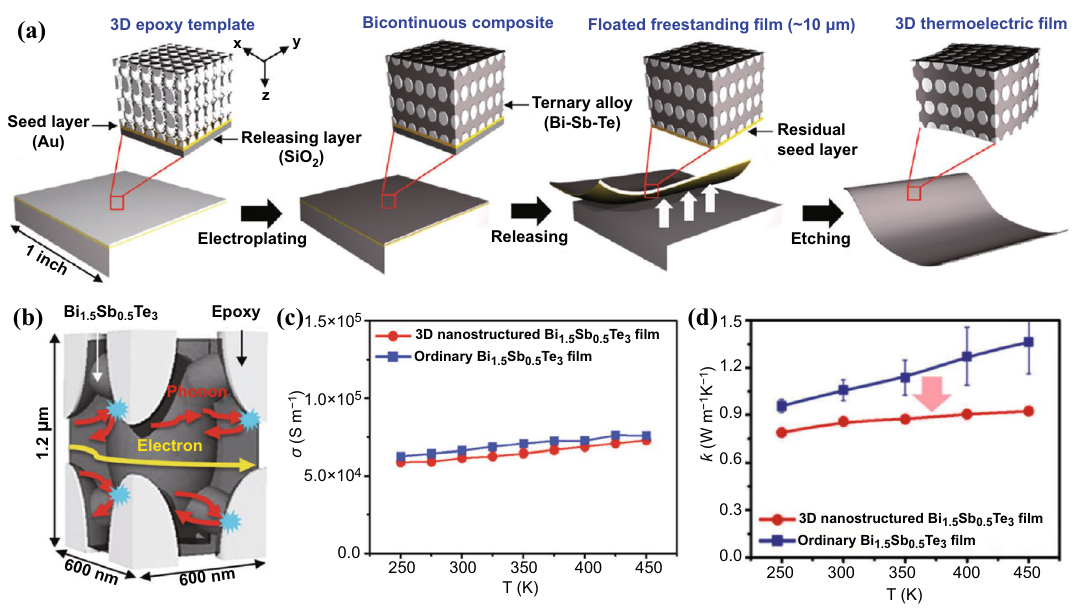
Fig. 16 a Schematic illustration of procedures for the fabrication of a freestanding and transferrable 3D nanostructured TE film. b Structural unit cell of a 3D nanostructured Bi 1.5 Sb 0.5 Te 3 film illustrating the concept of increasing phonon boundary scattering without altering electri- cal transport. Comparison of c electrical conductivity and d thermal conductivity of the 3D nanostructured and ordinaryBi 1.5 Sb 0.5 Te 3 films as a function of temperature. Adapted with permission from Ref. [209]